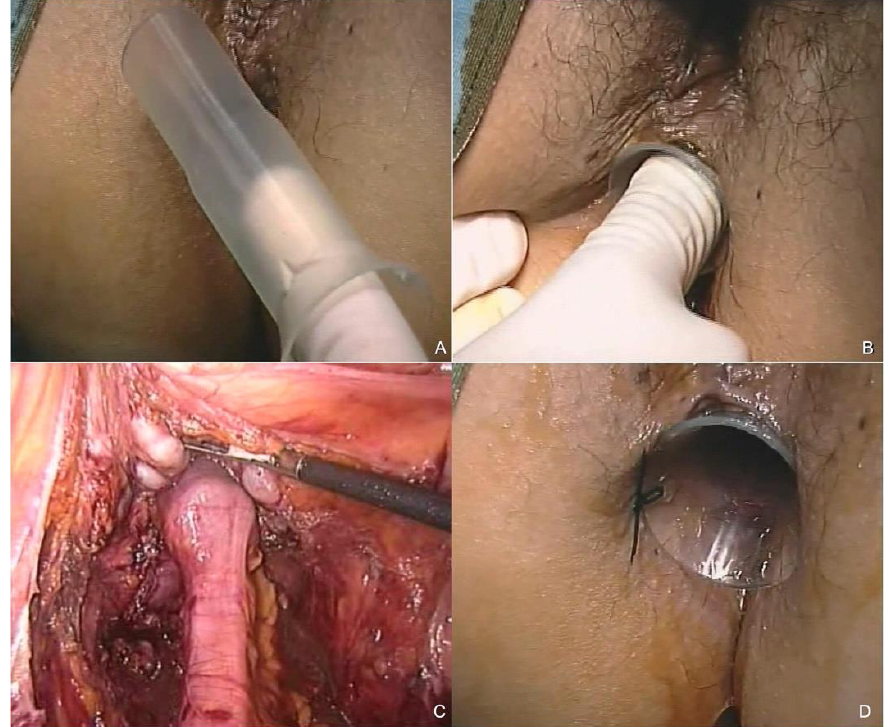
Figure 2. After the anastomosis has been performed, the lubricated tube ( A ) is inserted into the anal canal and placed to coat the anastomotic area, until the tube’s tongues contact the perineal skin ( B ). The proper position of the tube is checked by means of concomitant laparoscopic view ( C ). Final view after securing the tube to the perianal skin by two silk stitches ( D